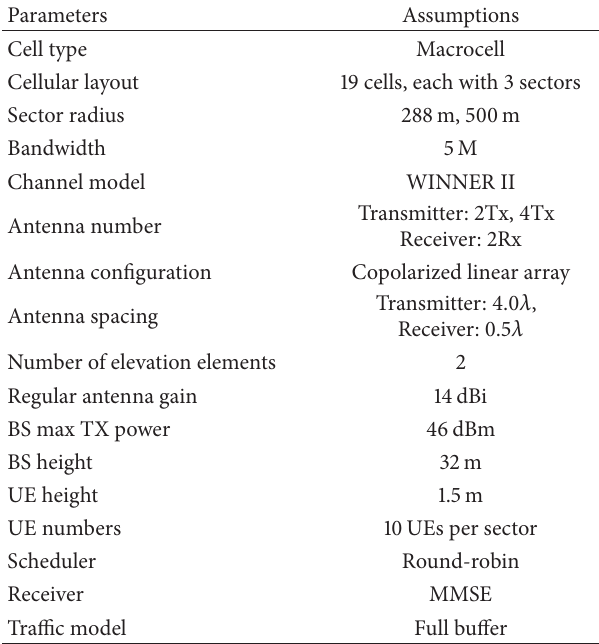
Table 1: Simulation configuration